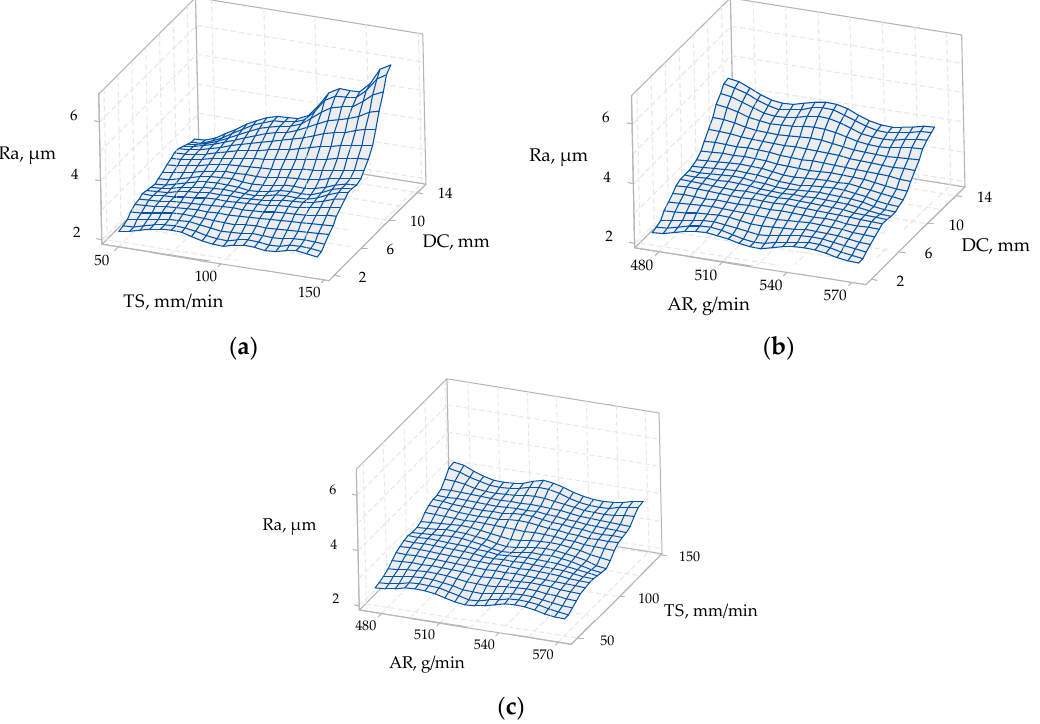
Figure 9. 3D surface plots of process parameters vs. surface roughness of 15 mm material thickness: ( a ) traverse speed (TS) vs. depth of cut (DC) on surface roughness ( Ra ); ( b ) abrasive mass flow rate (AR) vs. depth of cut (DC) on surface roughness ( Ra ); ( c ) abrasive mass flow rate (AR) vs. traverse speed (TS) on surface roughness ( Ra ).